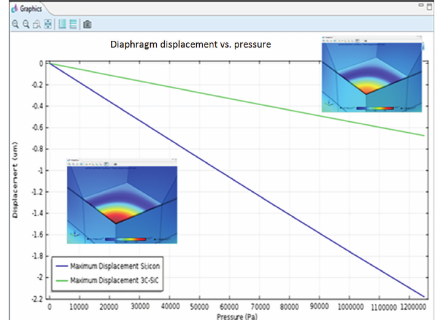
Figure 7: Plot of deflection of the diaphragm versus pressure.